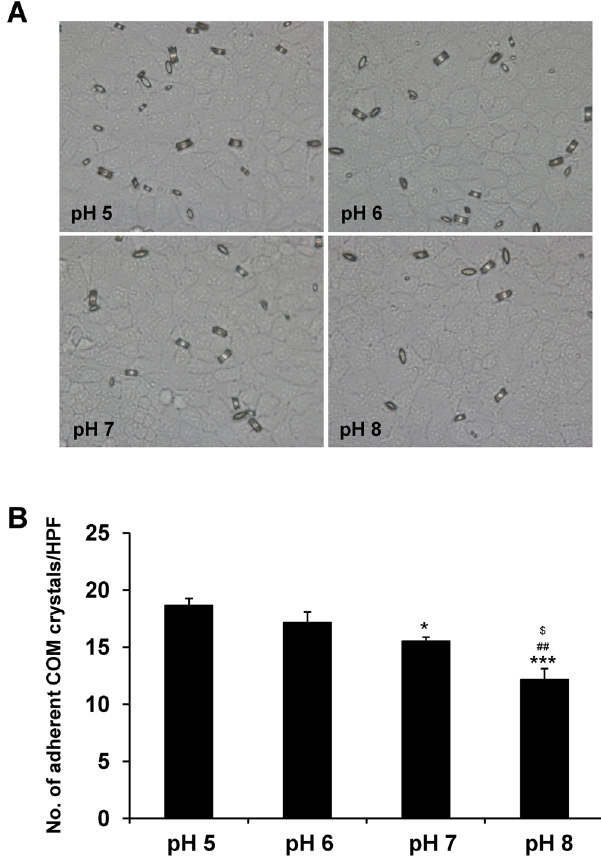
Figure 5. Effect of pH on COM crystal adhesion on renal tubular cells. Crystal-cell adhesion assay was performed using plain COM crystals under varying pH (from 5.0 to 8.0). ( A ) Microscopic examination of the crystals remained and adhered on the MDCK cell monolayer after washing in each condition (original magnification power was 400 × ). ( B ) Quantitative data of the adherent COM crystals from at least 15 randomized high-power fields (HPF) per culture well in each replicate. The data are reported as mean ± SEM of the data obtained from 3 independent experiments. * p < 0.05 vs. pH 5; *** p < 0.001 vs. pH 5; ## p < 0.01 vs. pH 6; $ p < 0.05 vs. pH